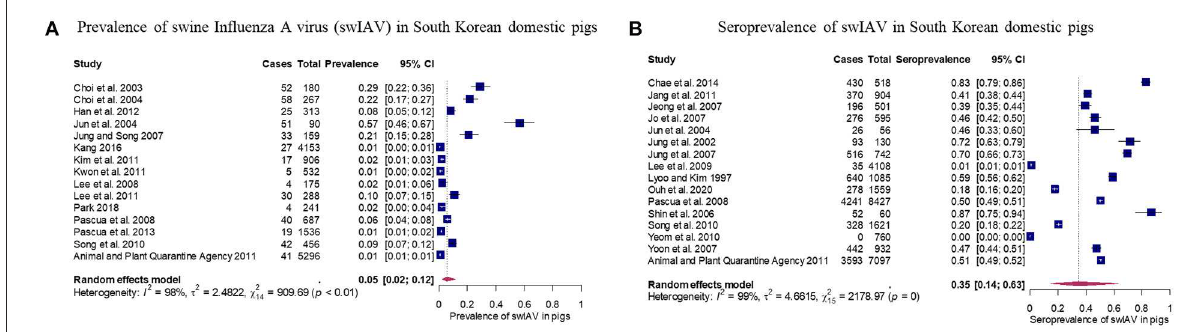
FIGURE2 Results of meta-analysis of prevalence and seroprevalence of swine influenza A virus (swIAV) in domestic pigs. (A) Forest plot of prevalence with 95% confidence interval (CIs) of swIAV in domestic pigs. (B) Forest plot of seroprevalence with 95% CIs of swIAV in domestic pigs. Size of the blue square corresponds to the weight of each study. Vertical dotted line symbolizes the overall effect size.